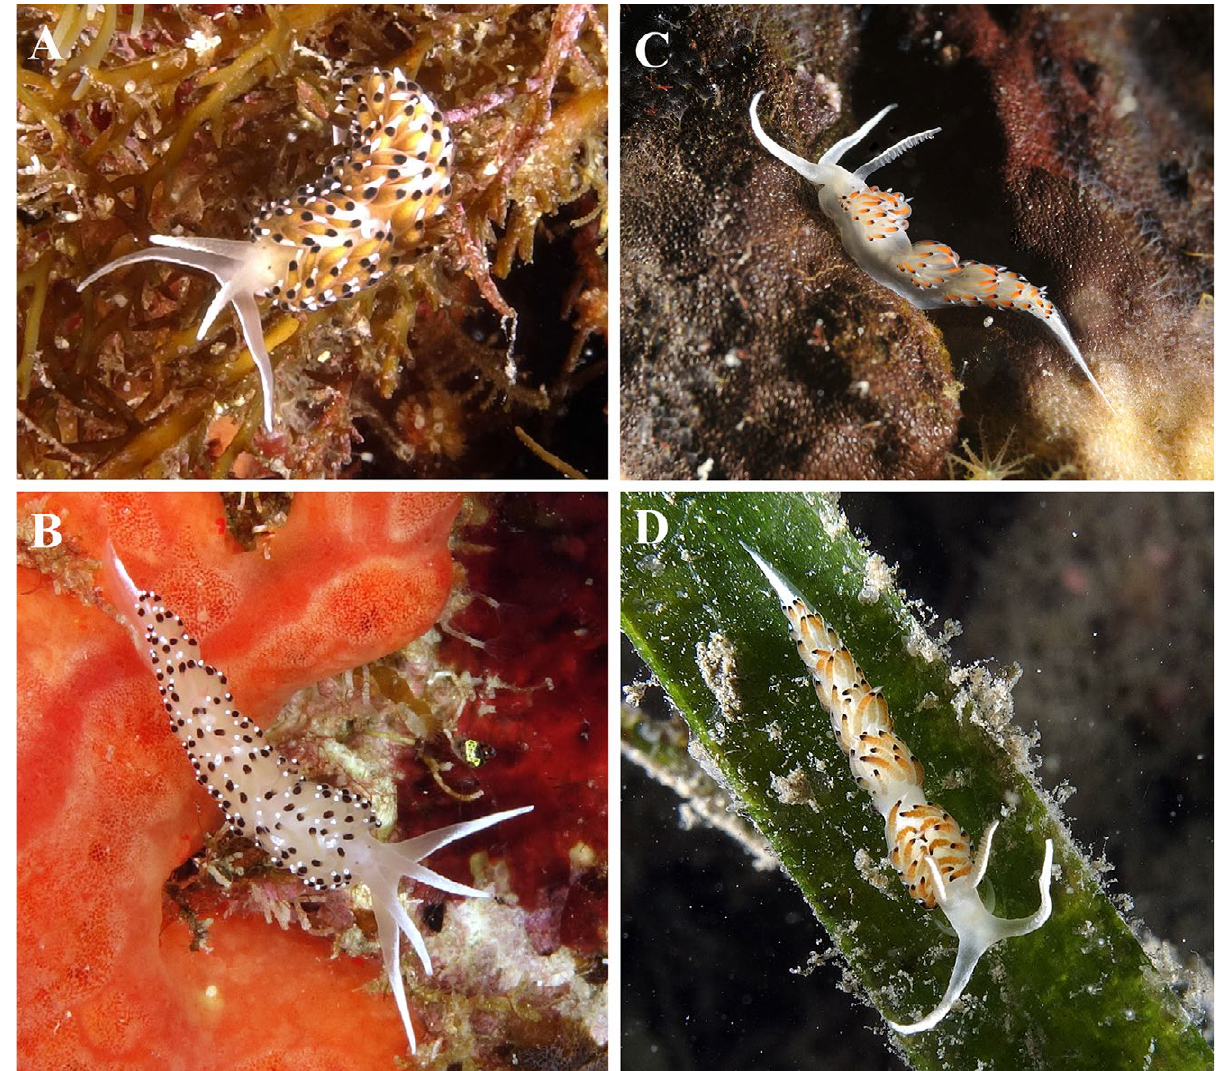
Fig. 2. – Underwater photographs showing the in situ individuals of C. elegans (A, B) and F. quatrefagesi (C, D). A, Lavezzi (41.341559°N 9.246254°E) Bonifacio, Corse, France, 8 m depth, 23/03/2013; length 10 mm. B, Capo Figari (40.994595°N 9.664622°E), Golfo Aranci, Italy, 12 m depth, 14/10/2013; length 10 mm. C, Lido del Sole (40.914482°N 9.566886°N), Olbia, Italy, 4 m depth, 05/11/2012; length 20 mm. D, Punta Saline (40.915168° N 9.576346°N) , Olbia, Italy, 5 m depth, 21/05/2014; length 20